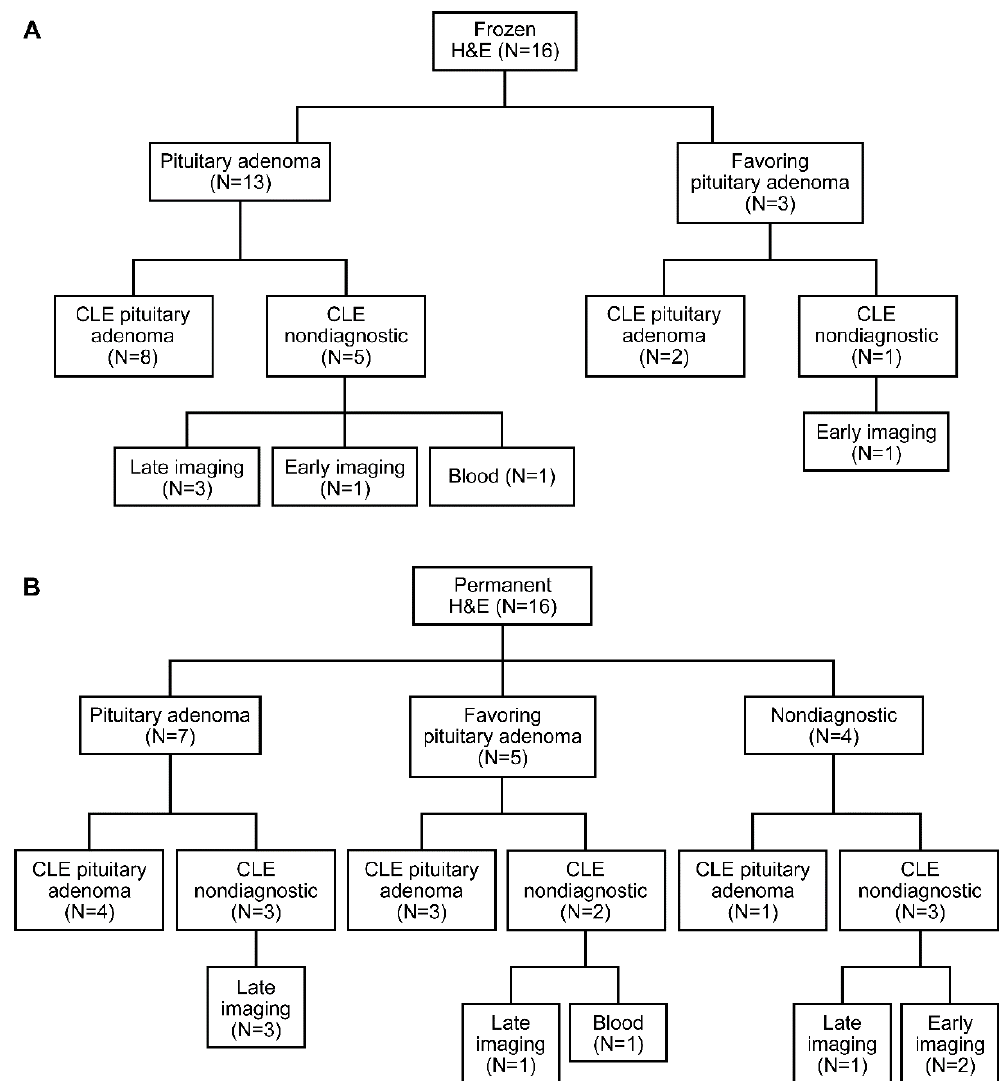
Figure 4. Study design flowchart showing confocal laser endomicroscopy (CLE) accuracy with ( A ) frozen hematoxylin and eosin (H&E) sections and ( B ) fixed permanent H&E sections used as the standard. Used with permission from Barrow Neurological Institute, Phoenix, Arizona.